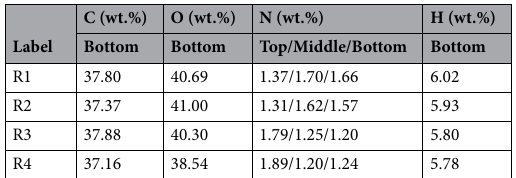
C (wt.%) O (wt.%) N (wt.%) H (wt.%) Label Bottom Bottom Top/Middle/Bottom